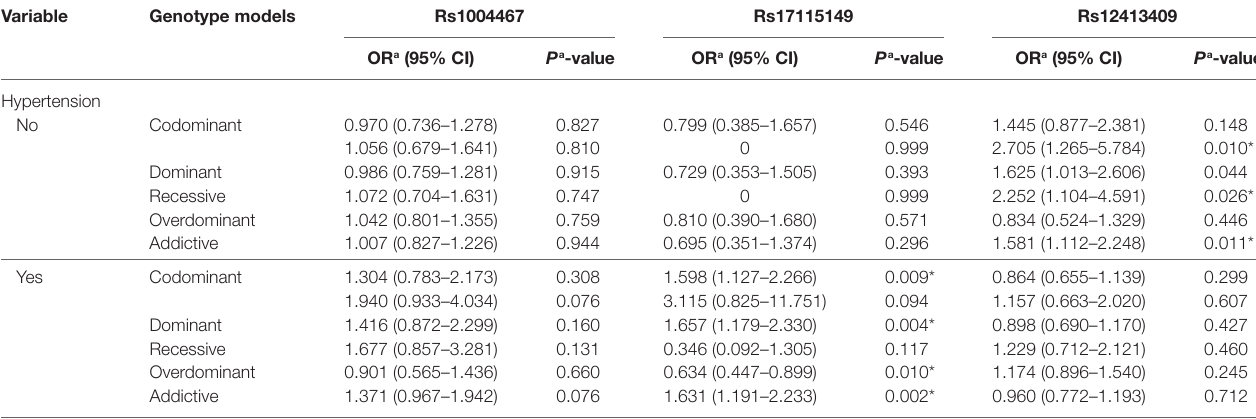
TaBle 3 | Stratified analysis of rs1004467, rs17115149, and rs12413409 polymorphisms on type 2 diabetes mellitus in the hypertension